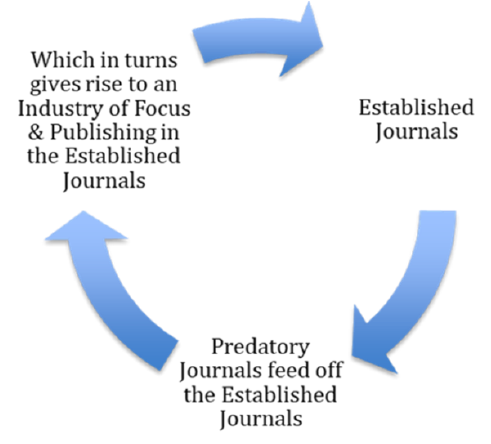
Figure 1 The symbiotic nature of the established & predatory publishing